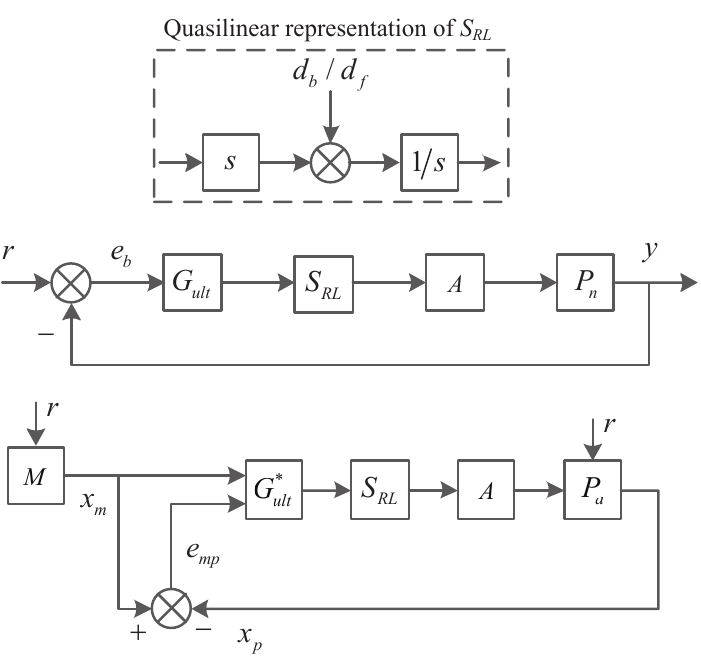
Figure 2. The reference controller with S RL